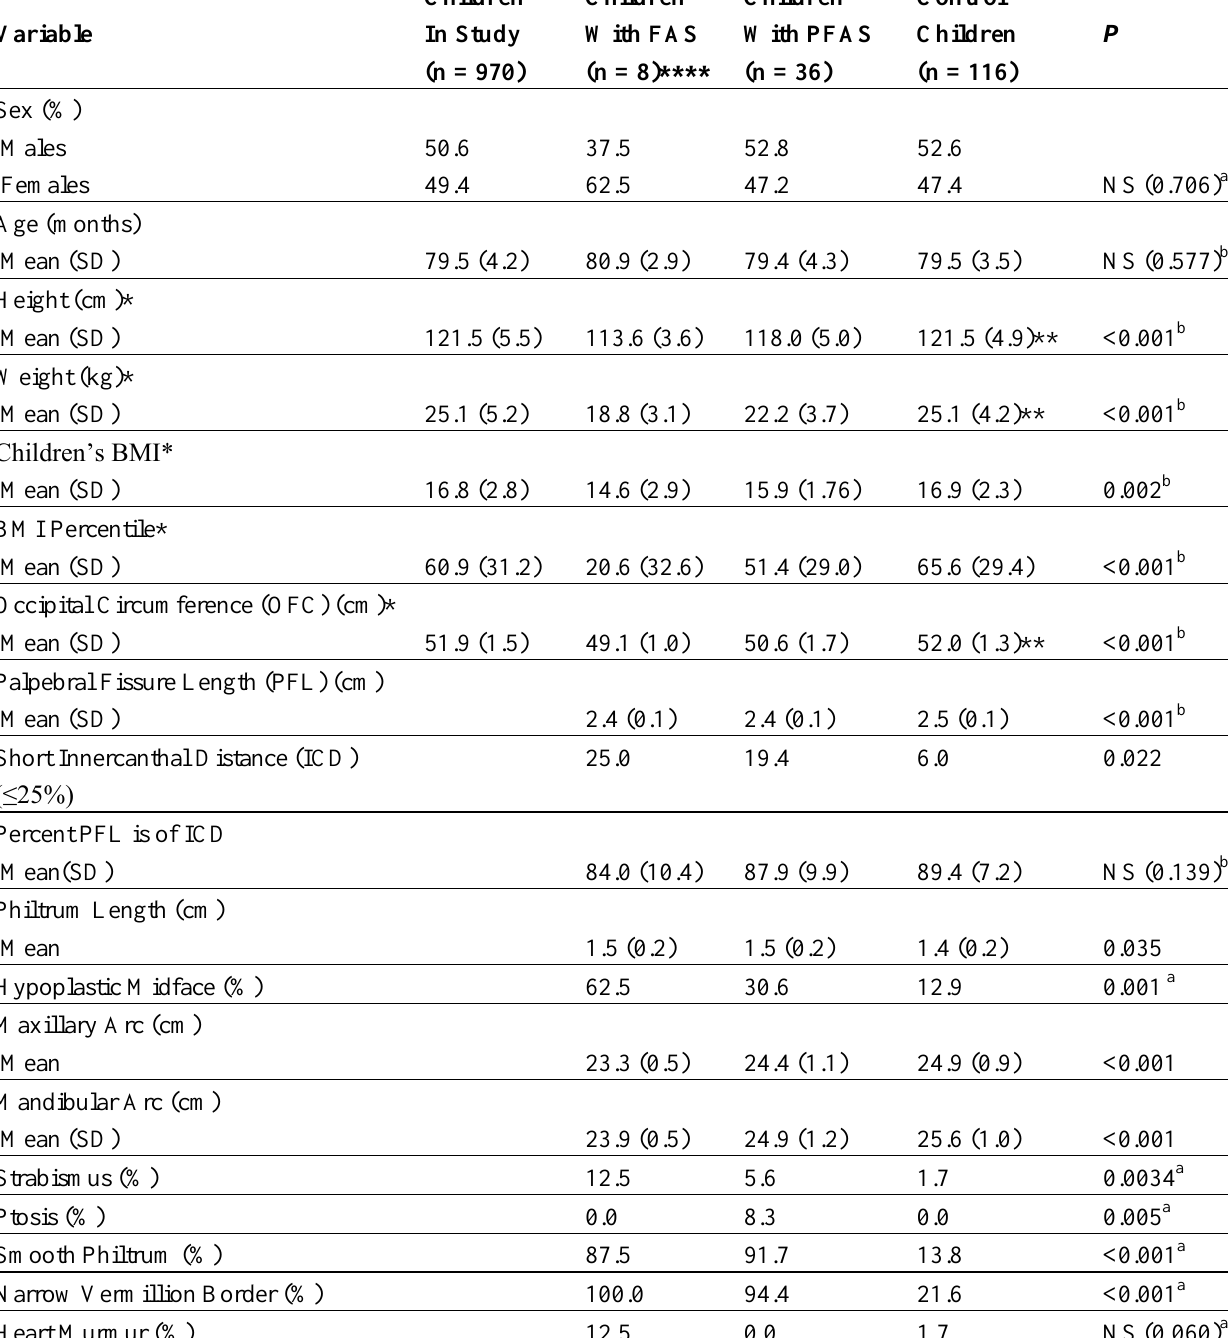
Table 1. Demographic and growth parameters for all study children, children with a final diagnosis of FAS, partial FAS, and randomly selected controls: Lazio Region,